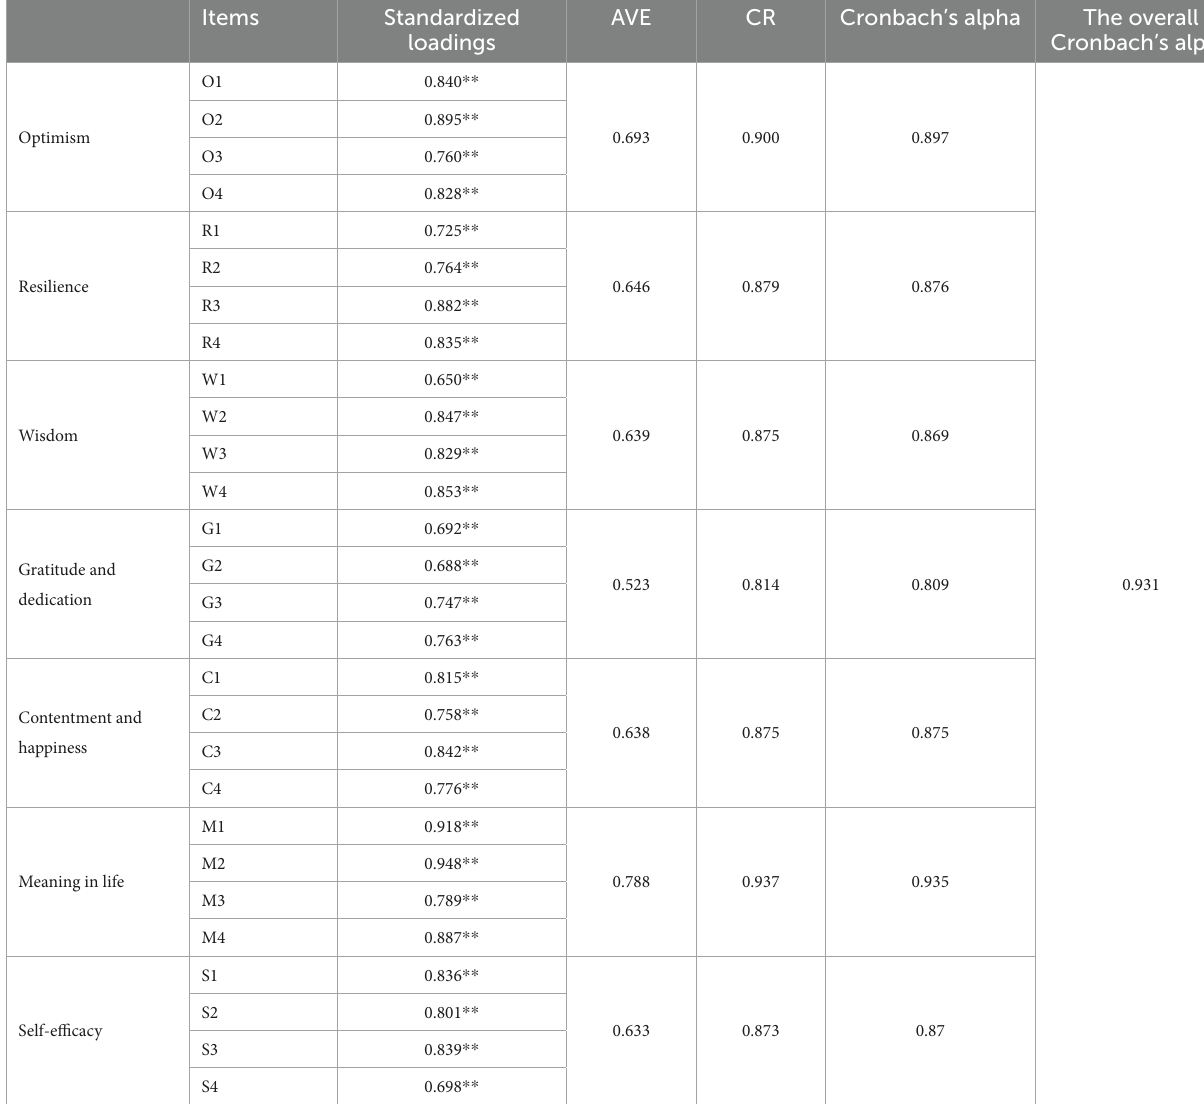
TABLE 4 Results of reliability and validity of the revised PsyCap scale ( N = 370).